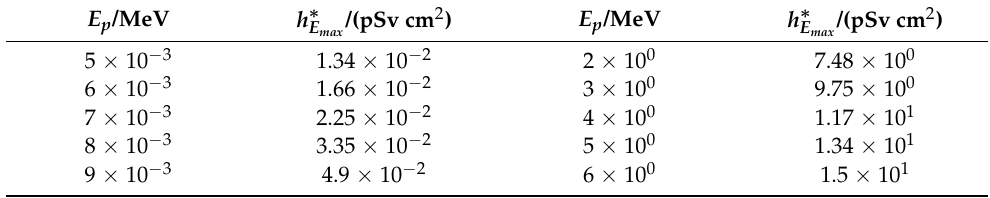
Table A1. Conversion coefficients from photon fluence to ambient dose. (ICRP 166, Table